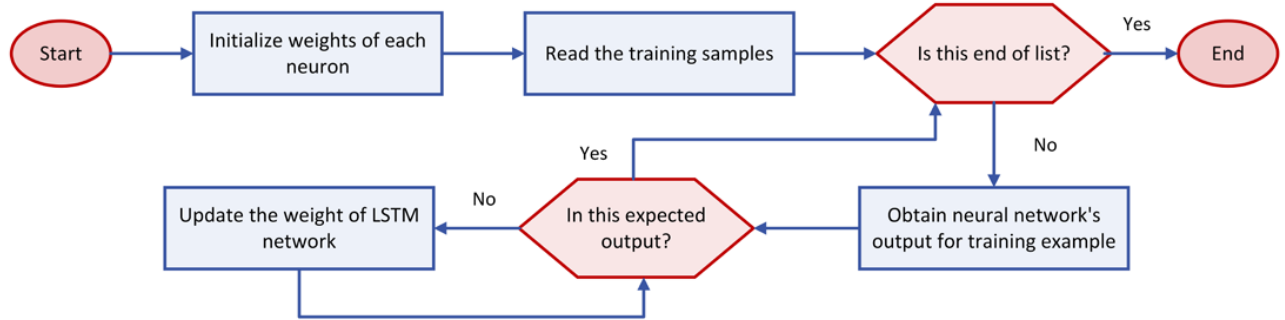
Figure 3. LSTM model’s flow chart.